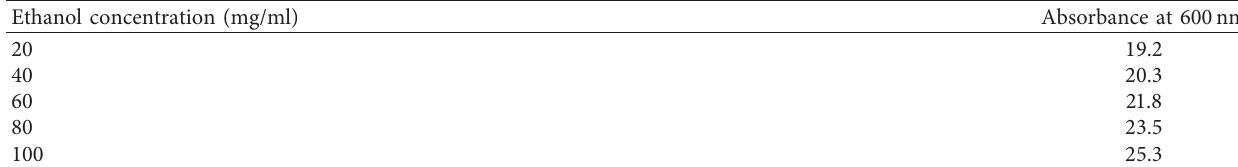
Table 3: Estimation of known ethanol concentration by using UV-vis spectrophotometer. Ethanol concentration (mg/ml)